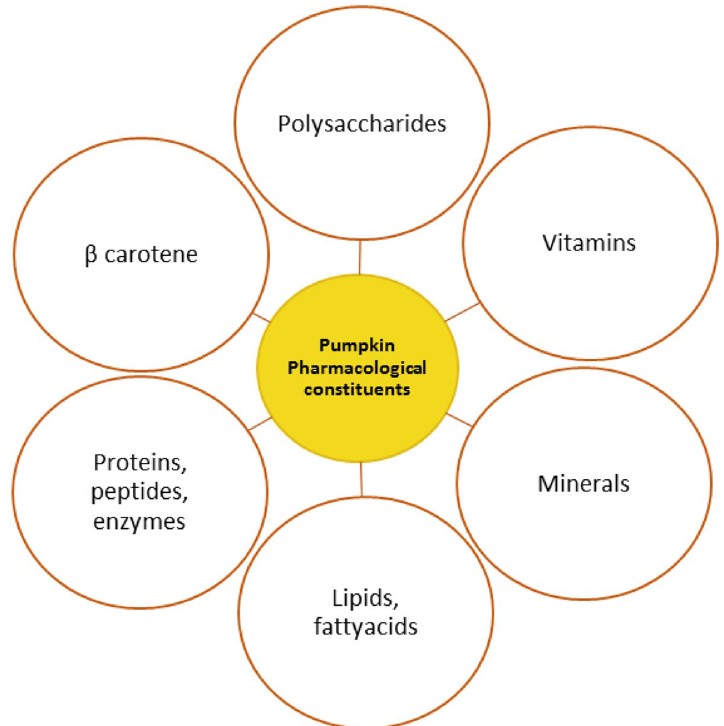
Fig. 3 Functional and pharmacological constituents of